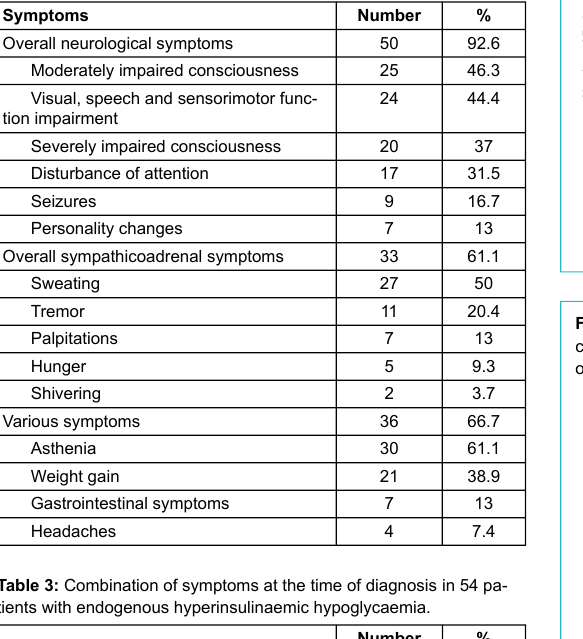
Table 2: Overview of main symptoms in 54 patients with confirmed en- dogenous hyperinsulinaemic hypoglycaemia.